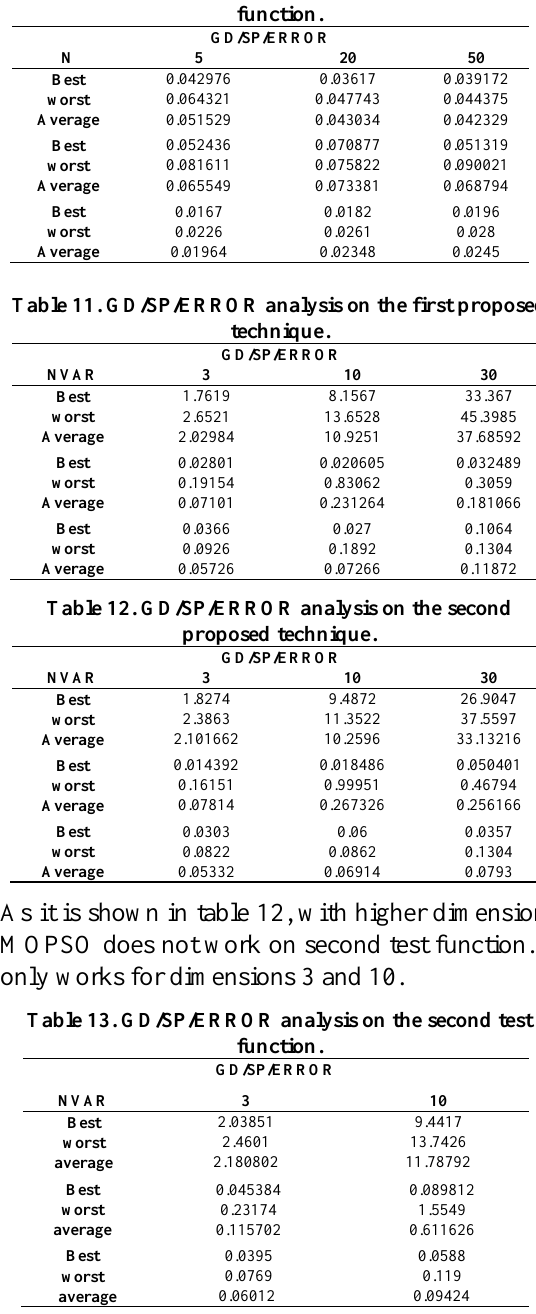
Table 10. GD/SP/ERROR analysis on the third test